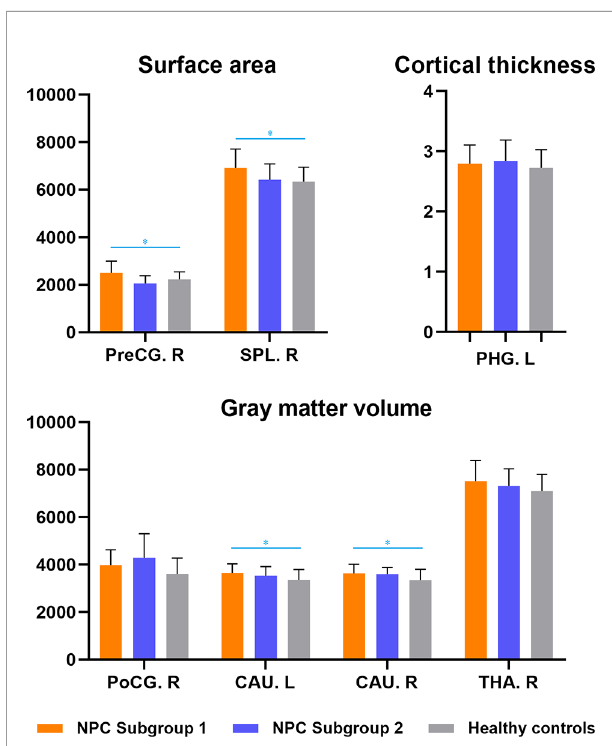
FIGURE 2 | Subgroup analyses of structural brain abnormalities in nasopharyngeal carcinoma patients with and without depression. NPC Subgroup 1-patients with depressive symptoms; NPC Subgroup 2-patients without depressive symptoms. * indicated inter-group differences with statistical signi fi cance. PHG, parahippocampal gyrus; PreCG, precentral gyrus; PoCG, postcentral gyrus; SPL, superior parietal lobule; CAU, caudate; THA, thalamus; R, right; L,